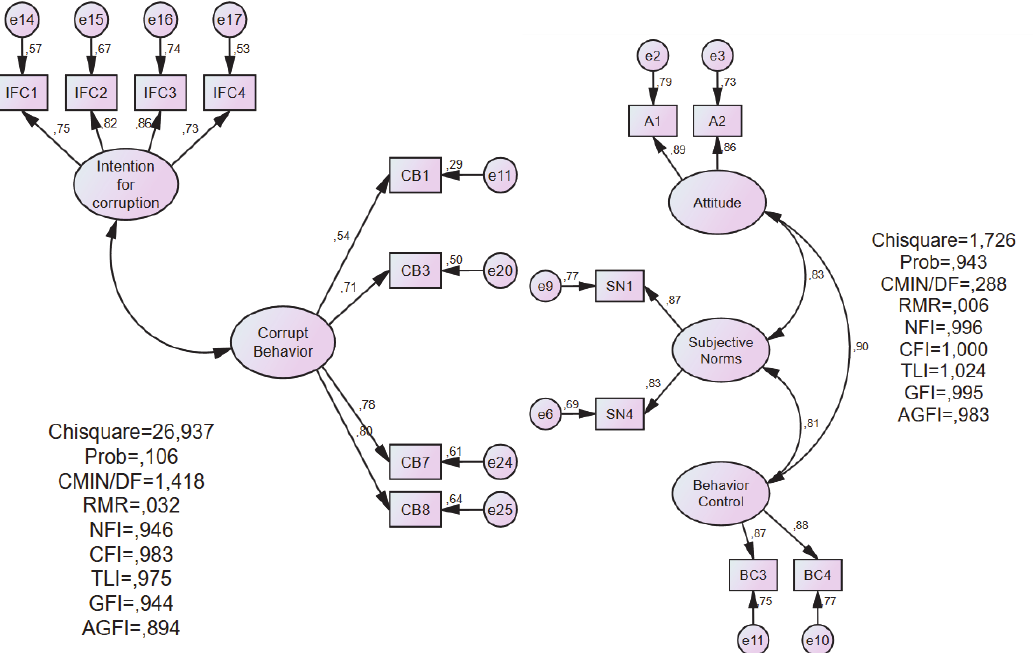
Fig. 1. Goodness of Fit Tests with Dependent